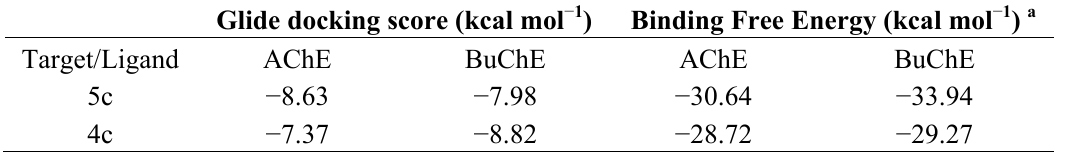
Table 2. Protein-ligand binding affinities estimated through molecular docking and MM-GBSA